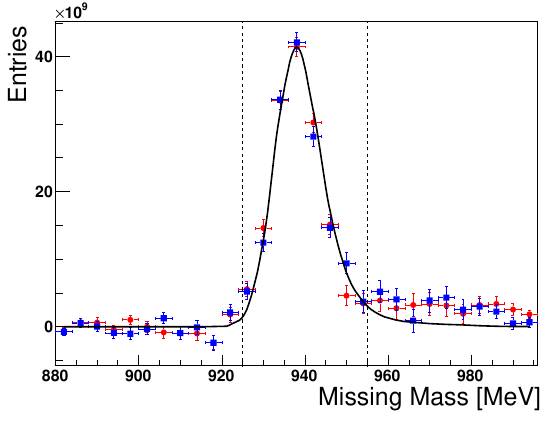
Figure 2. Compton scattering on the proton: Missing mass for the incoming photon energy range 79–98 MeV and polar angles for the scattered photon covering the range 30 ◦ < θ < 155 ◦ . The data were taken with linearly polarized photons with polar- ization planes either parallel (red circles) or perpendicular to the horizontal plane (blue squares). The black curve shows the corre- sponding distribution obtained from our Monte Carlo simulation. The dashed lines indicate the cut on the missing mass applied in the analysis. Figure taken from Ref.